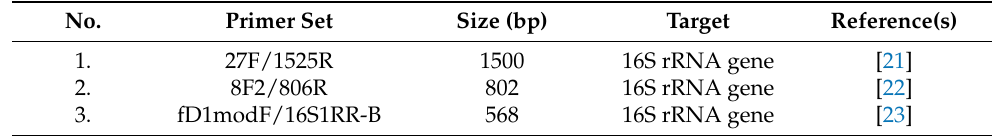
Table 1. The primers used in this study. No. Primer Set Size (bp) Target